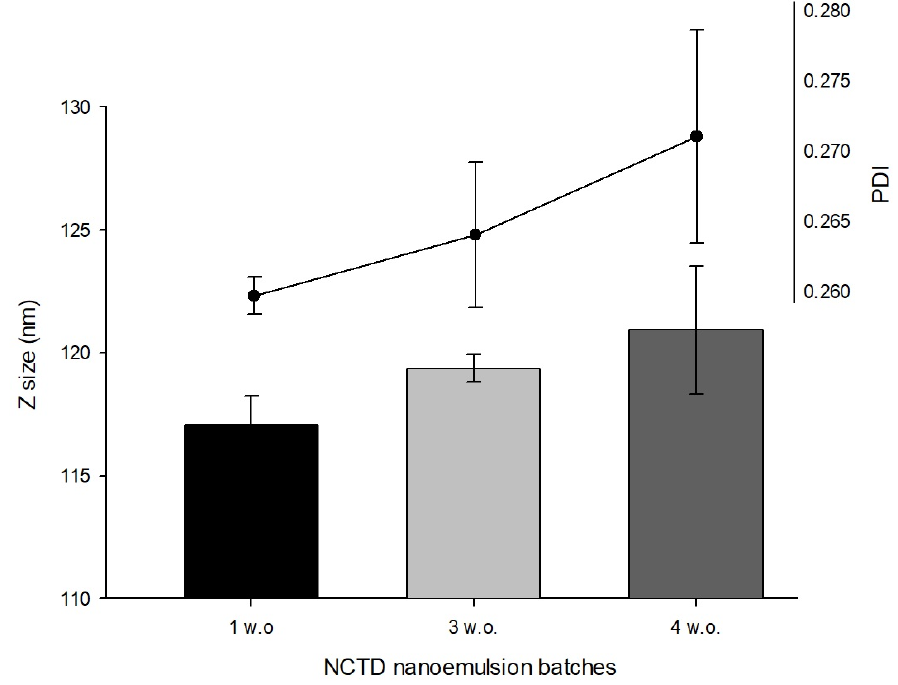
Figure 2. Droplet size (Z size) and polydispersity index (PDI) of NCTD nanoemulsion